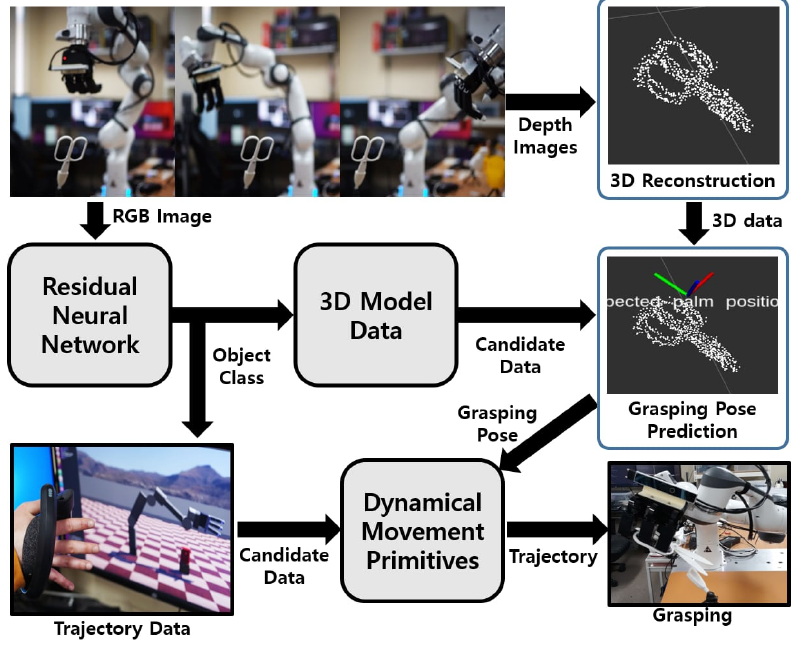
Figure 5. System